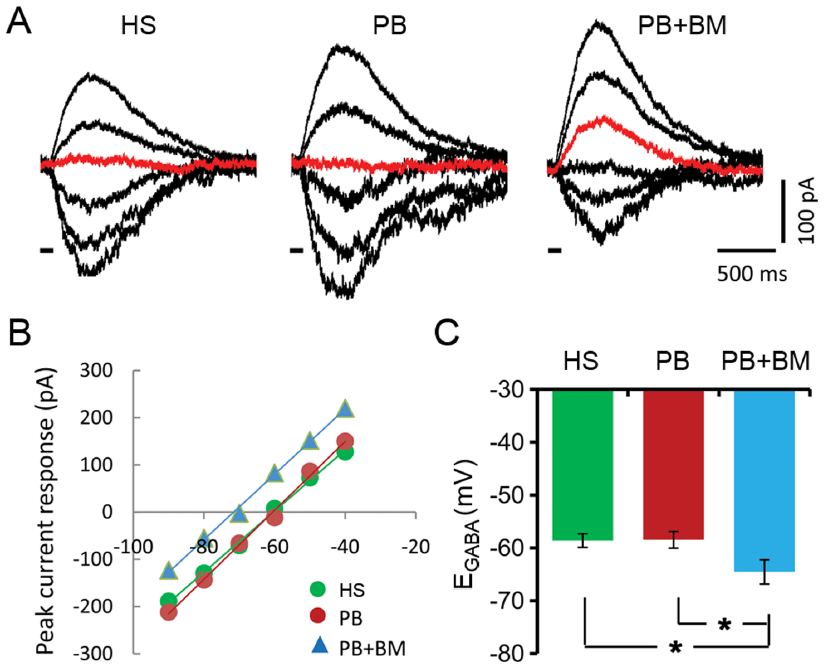
Figure 7. The combination of phenobarbital and bumetanide alter E GABA in CA1 neurons from slices removed at 24 hr post-hypoxic seizures. GABA-evoked currents were measured from hippocampal slices taken from rats (n=6) 24 hr after hypoxia-induced seizures. (A) Typical examples of GABA-evoked currents in CA1 neurons at various holding potentials after application of phenobarbital (PB, 100 mM), and phenobarbital in combination with bumetanide (PB + BM). Treatment effects were compared to normal conditions (HS) prior to drug administration. (B) Current– voltage curves for the recordings shown in A. The data points were fitted with a straight line. (C) Summary of the reversal potential of GABA-evoked currents under different recording conditions: control (HS, 2 58.61 6 1.28 mV), phenobarbital only (PB, 2 58.46 6 1.58 mV), and phenobarbital in combination with bumetanide (PB + BM, 2 64.53 6 2.30 mV). Error bars indicate SEM. * p , 0.05.